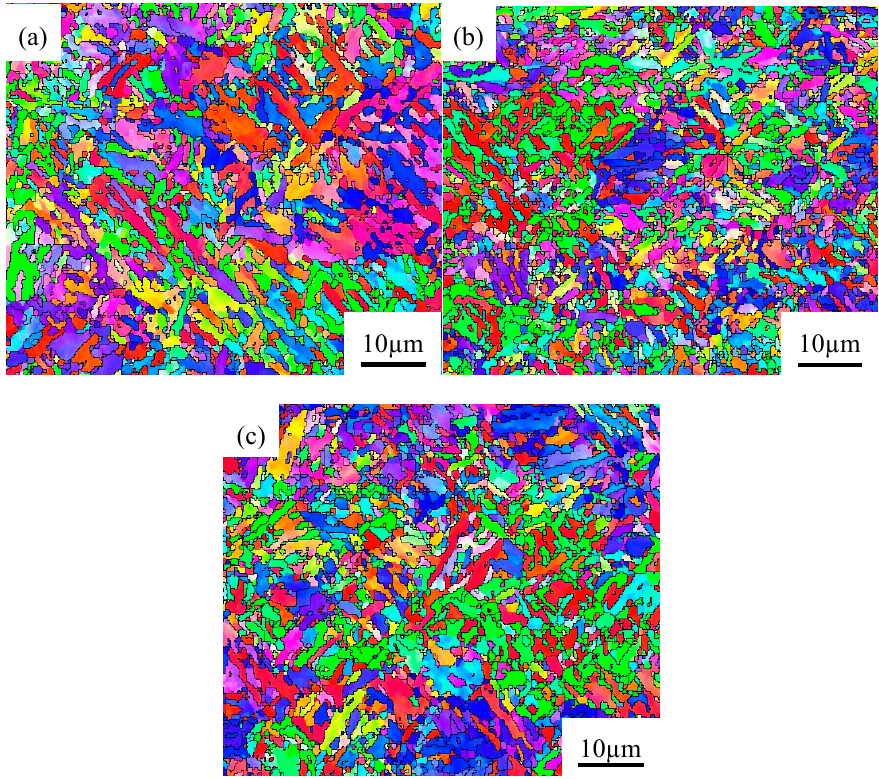
Figure 10. Variation in the efficiency of power dissipation with true strain at the deformation temperature of 1100 °C and 1150 °C and the strain rate of 0.1 s − 1 .